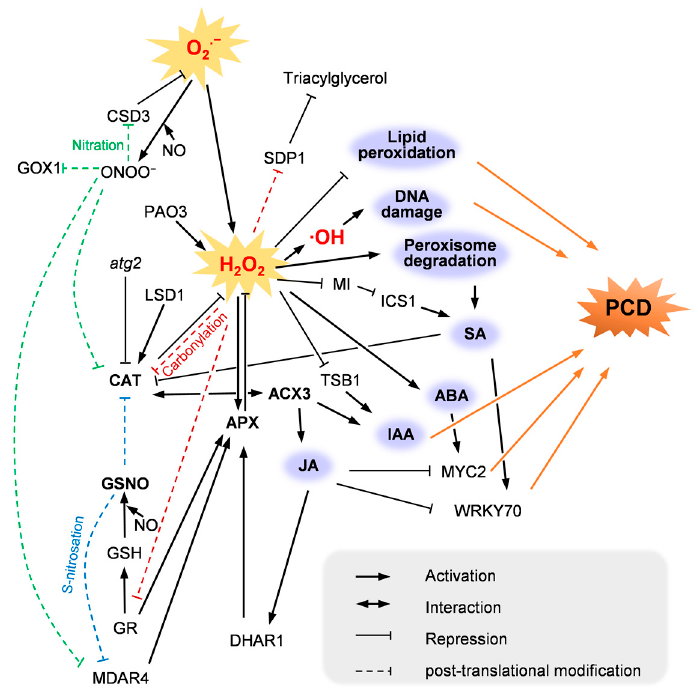
Figure 2. The regulatory mechanism of peroxisome-derived ROS involved in PCD. LSD1, Lesion Simulating Disease 1; ATG2/PEUP1, Autophagy-related 2/Peroxisome Unusual Positioning 1; SDP1, sugar-dependent 1; ICS1, isochorismate synthase 1; TSB1, Tryptophan Synthase Beta-Subunit 1; GSNO, S -nitrosoglutathione; NO, nitric oxide; ONOO − , peroxynitrite; ·OH, hydroxyl radical; MI, myo -inositol; SA, salicylic acid; ABA, abscisic acid; IAA, indole-3-butyric acid; JA, jasmonic acid.